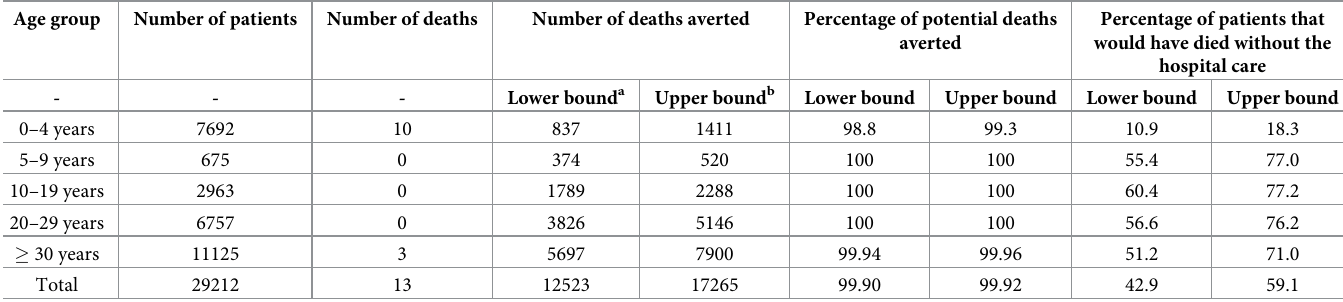
Table 6. Estimated deaths averted by taking care of patients at icddr,b Dhaka Hospital during the 2018 diarrhea epidemic (N =